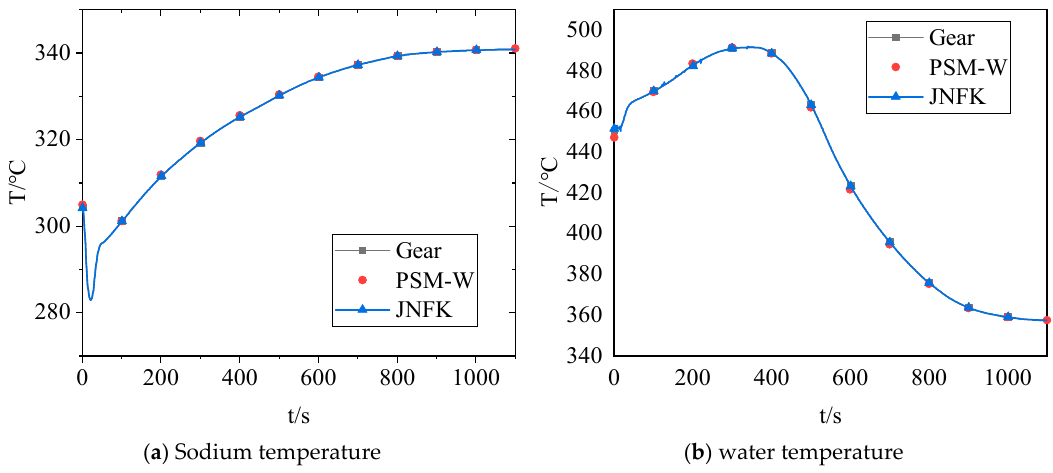
Figure 5. B1-B transient outlet temperature comparison.